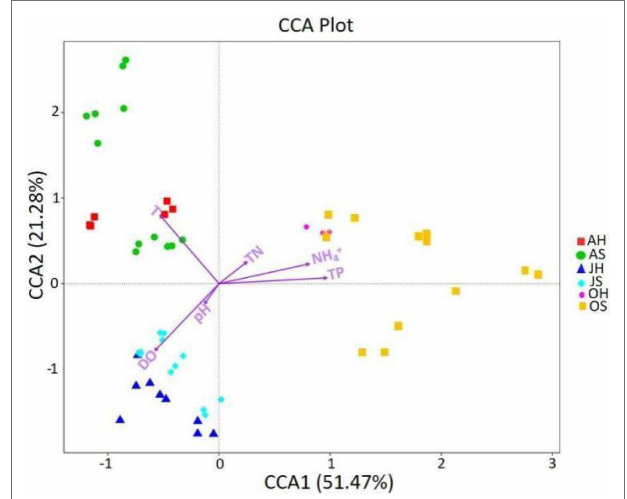
FIGURE 6 | The canonical correspondence analysis (CCA) plot investigating correlations between environmental factors and the epiphytic bacteria at the OTU level. DO, dissolved oxygen; TN, total nitrogen; TP, total phosphorus; and NH 4+ , ammonia